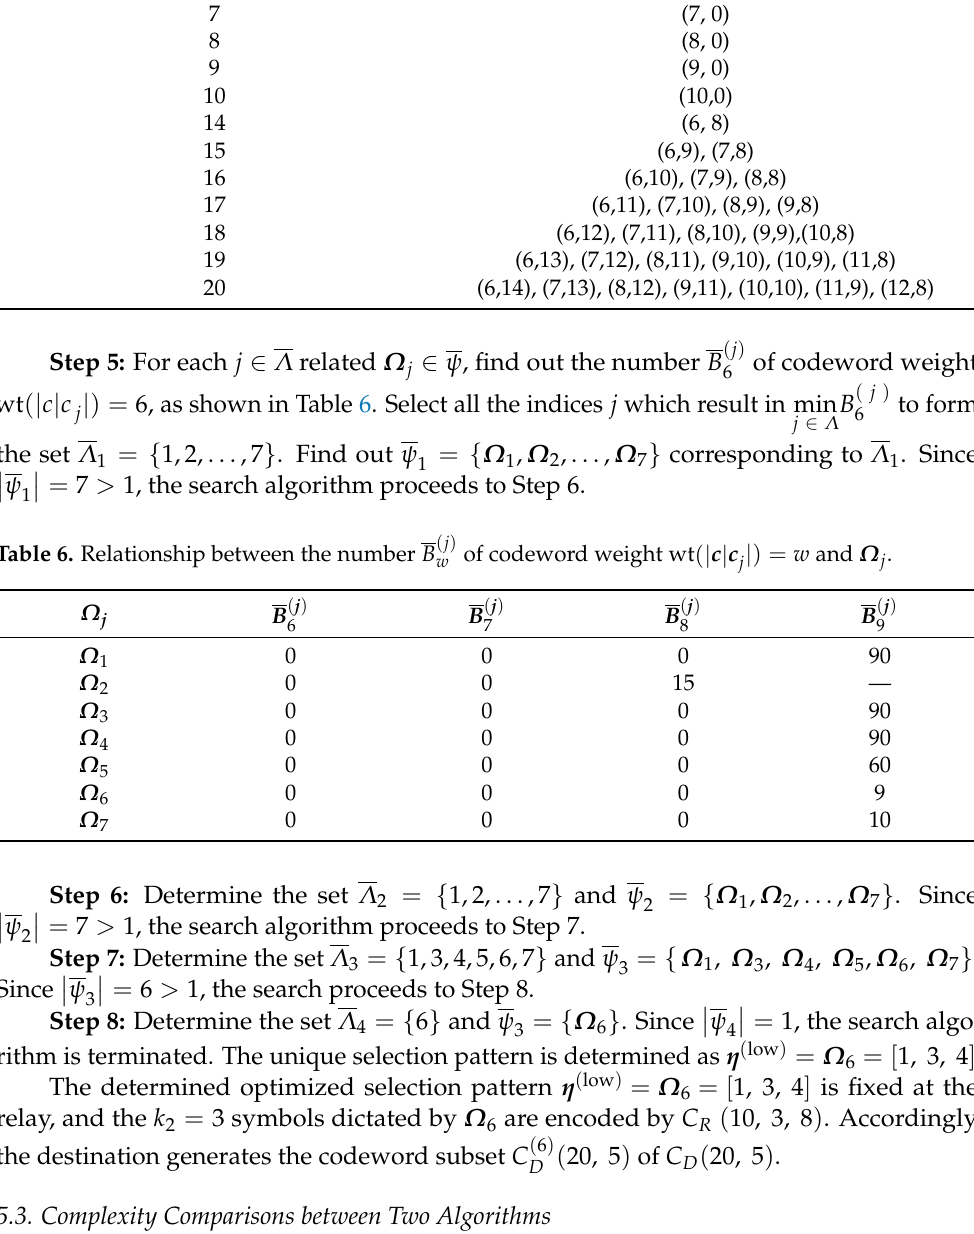
Table 6. Relationship between the number B